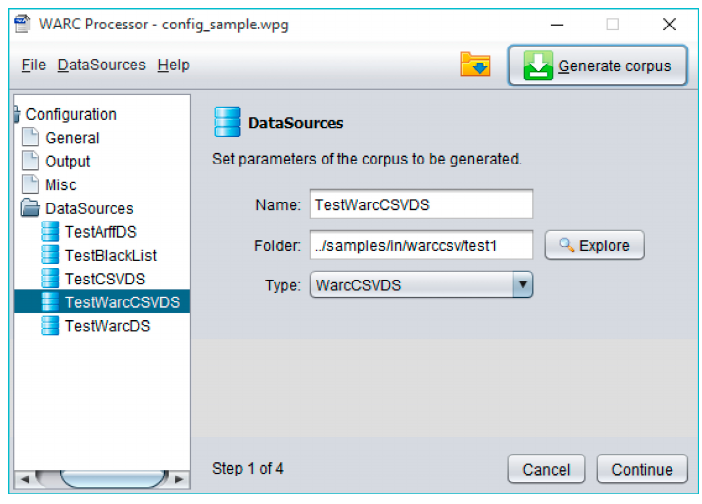
Figure 6. Specific data source configuration in WARCProcessor.